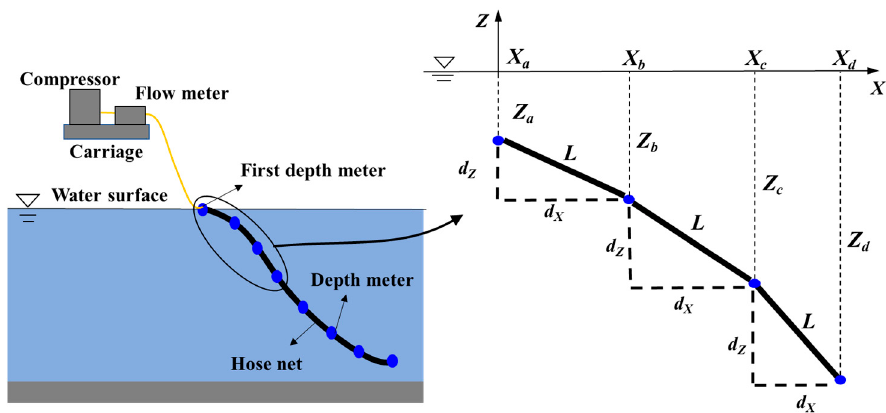
Figure 6. Estimating the method of two-dimensional geometry of the hose net.